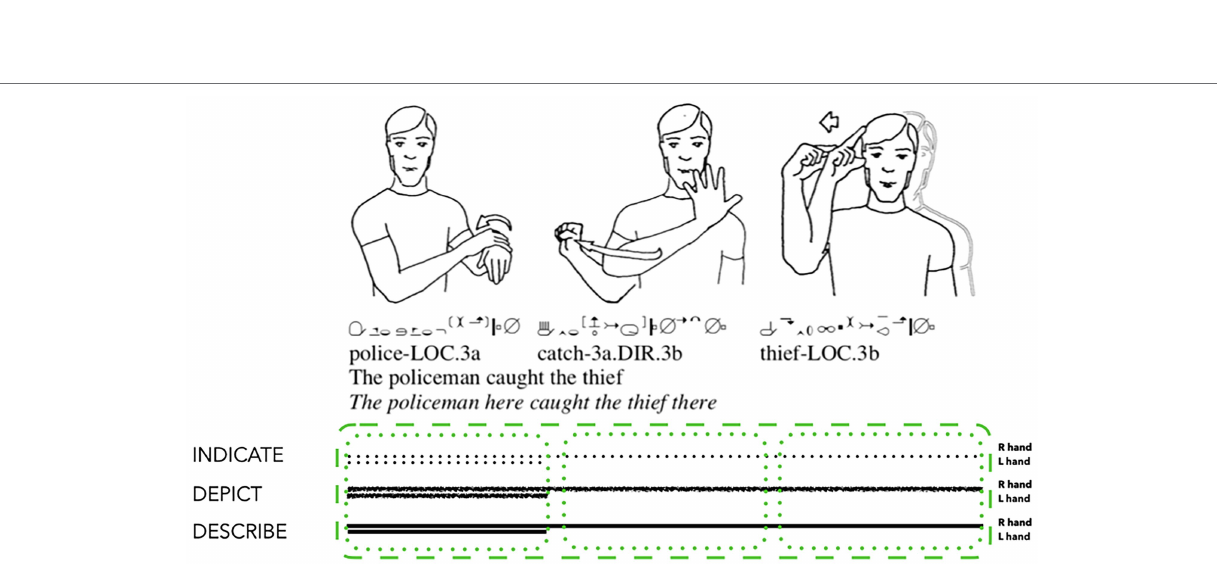
FIGURE 7 | Composite utterance produced by a deaf signer of Auslan (adapted from Johnston, 1996: 72 and reproduced with permission from the author and Taylor and Francis Group, LLC., a division of Informa plc.).